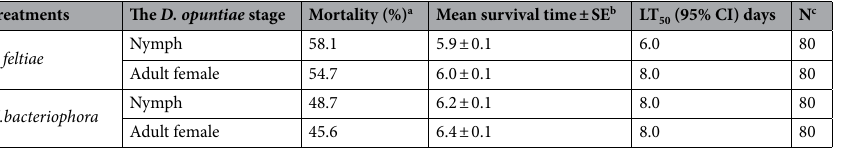
Table 2. Mortality (%), mean survival time, and LT 50 (days) of Dactylopius opuntiae -treated nematode isolates with concentration 75 IJs cm −2 . a Abbott-corrected percentage mortality of D. opuntiae nymphs and adults female at the end of experiment. b The mean survival time and its standard error. c Total number of D. opuntiae in bioassay.